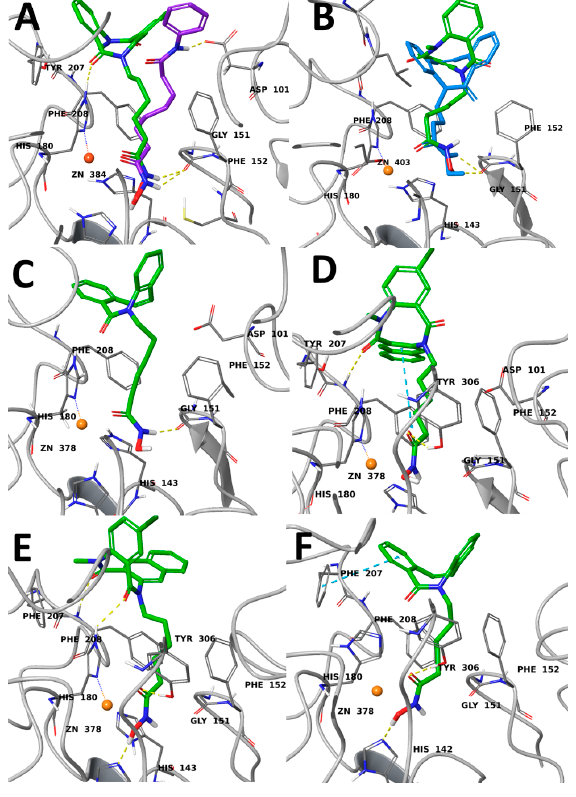
Figure 5. Representative L − R virtual complexes of ( A ) 7e (rendered in green) and Vorinostat (violet) in the binding pocket of HDAC1 (PDBid: 5ICN), ( B ) 7e (green), and 7i (blue) in the binding pocket of HDAC4 (PDBid: 2VQM), ( C ) 7k (green) in binding pocket of HDAC7 (PDBid: 3C0Z), ( D ) 7t (green) in the binding pocket of HDAC2 (PDBid: 4LXZ), ( E ) 7t (green) in the binding pocket of HDAC6 (PDBid: 5EDU) and ( F ) 7k (green) in the binding pocket of HDAC8 (PDBid: 1T69). Yellow dashed lines indicate hydrogen bonds, whereas blue indicate aromatic interactions. Zinc ion is rendered in orange.